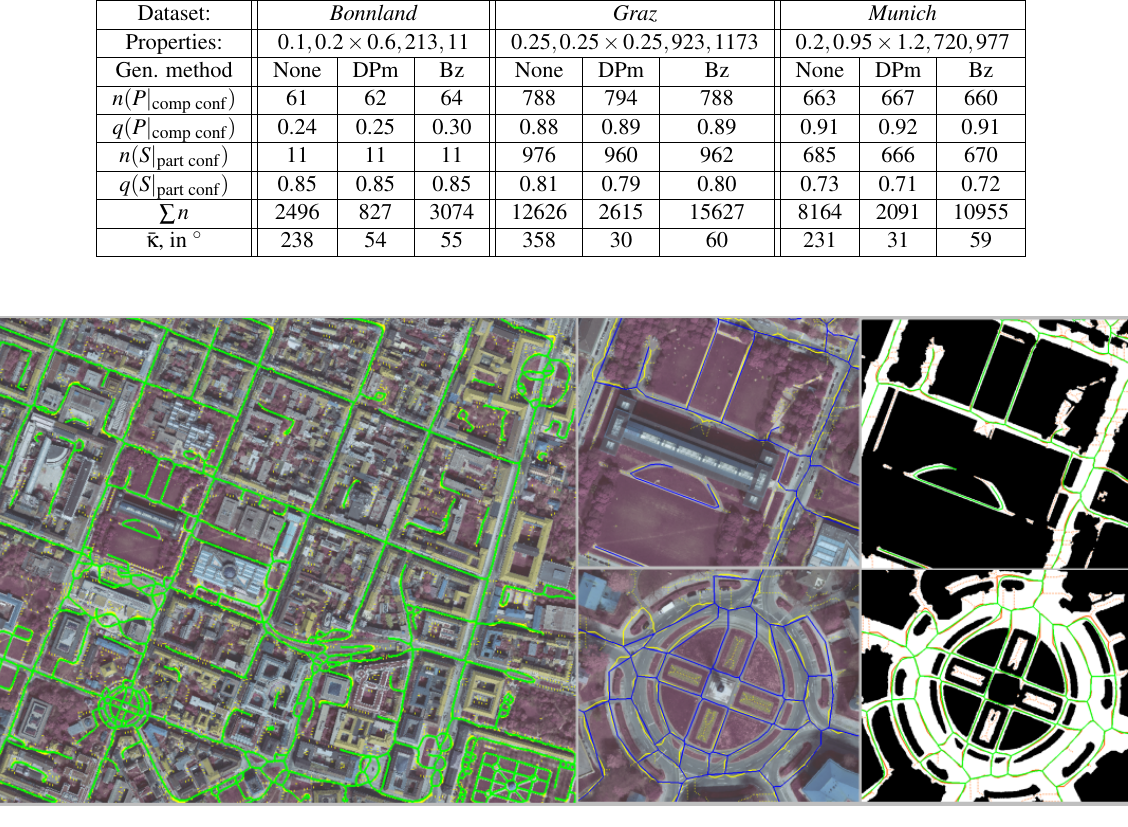
Figure 5: Results for the dataset Munich . Left: road segments drawn into the orthophoto. Top row, middle and right: detailed view of the results superposed with the orthophoto. Bottom row: middle and right: detailed results superposed the classification